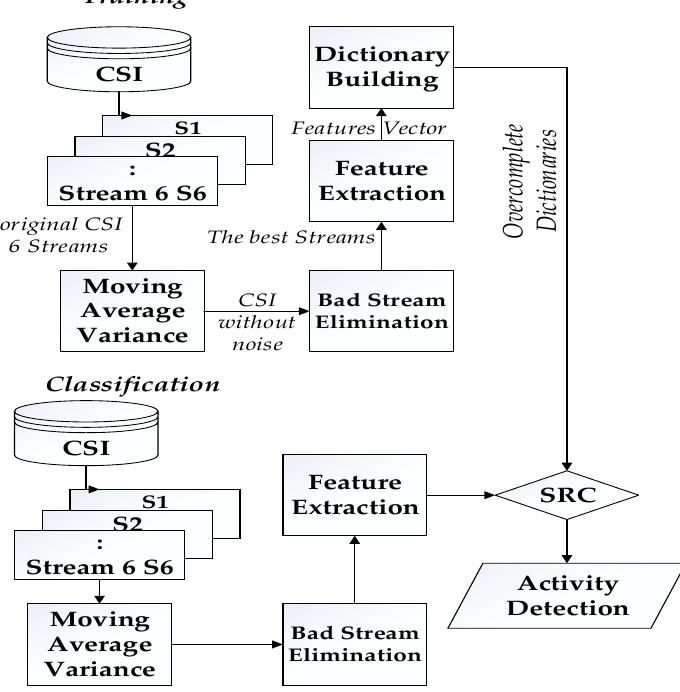
Figure 1. System architecture and workflow, Channel State Information (CSI); Sparse Representation Classification